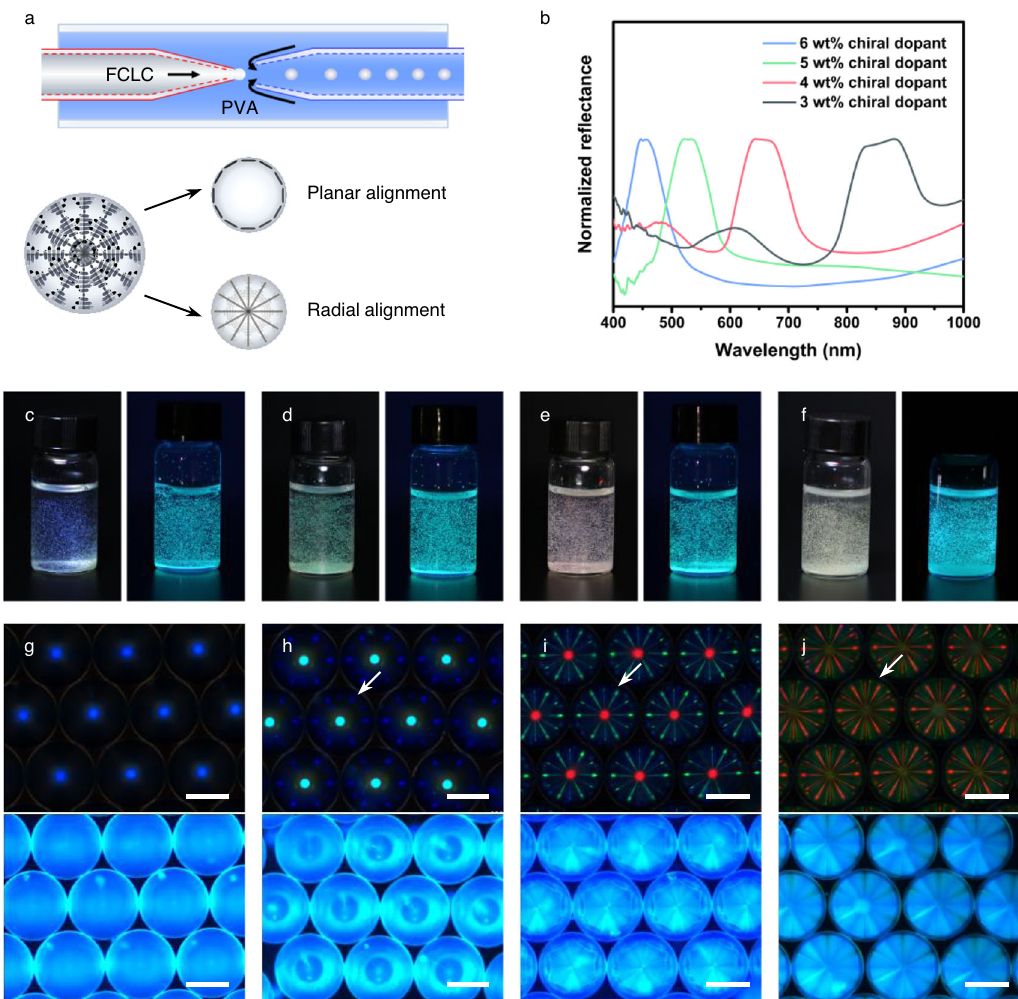
Fig. 3 FCLC microdroplets fabricated by capillary micro fl uidic technique. a Schematic illustration to show the capillary micro fl uidic device used to fabricate the FCLC microdroplets. The hydrophobic and hydrophilic surfaces of the capillaries are denoted in red and blue. The 5 wt% PVA aqueous solution is used as continuous phase to facilitate planar alignment of the LC molecules and radial alignment of the helical axes. b Normalized re fl ectance spectra of the FCLC microdroplets containing 6, 5, 4, 3 wt% chiral dopants, respectively. c – f Photographs of blue, green, red, and infrared FCLC microdroplets to show striking re fl ection colors under white light and fl uorescent color upon UV irradiation. g – j POM images of blue, green, red, and infrared monodisperse FCLC microdroplets in hexagonally close-packed arrays to show photonic cross-communication and fl uorescent patterns. Additional lines caused by double re fl ection are denoted by white arrows. The scale bar is 100 μ